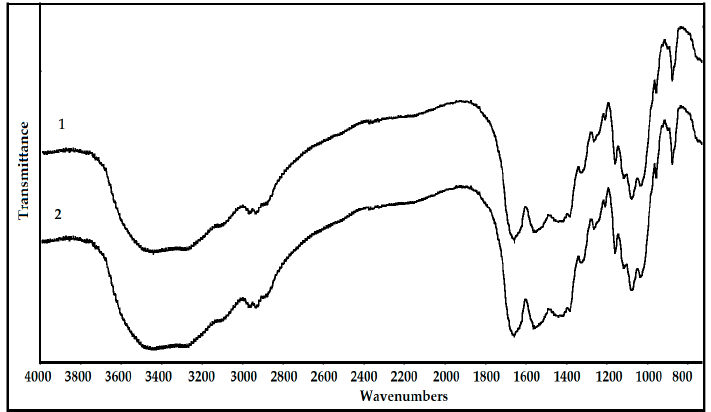
Figure 5. Fourier-transform infrared spectroscopy (FTIR) profile of chitin from shrimp head powder (SHP) (1), and chitin from fSHP (2).